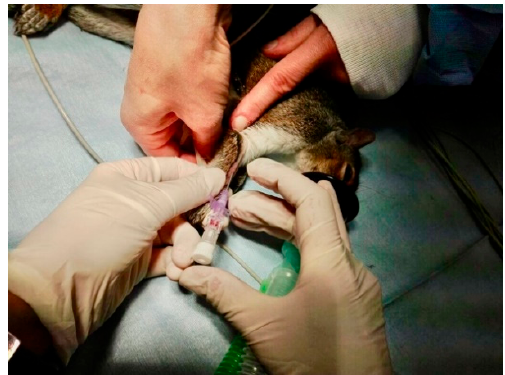
Figure 3. Aseptical catheterization of a cephalic vein in a gray squirrel under anesthesia receiving oxygen by a mask.